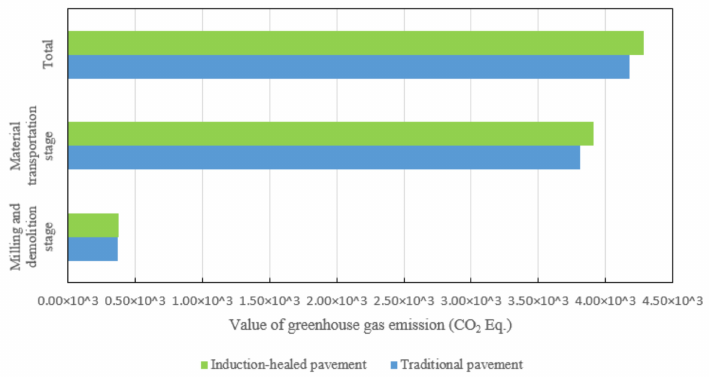
Figure 14. Greenhouse gas emissions of two asphalt pavements’ in milling and demolition stages.